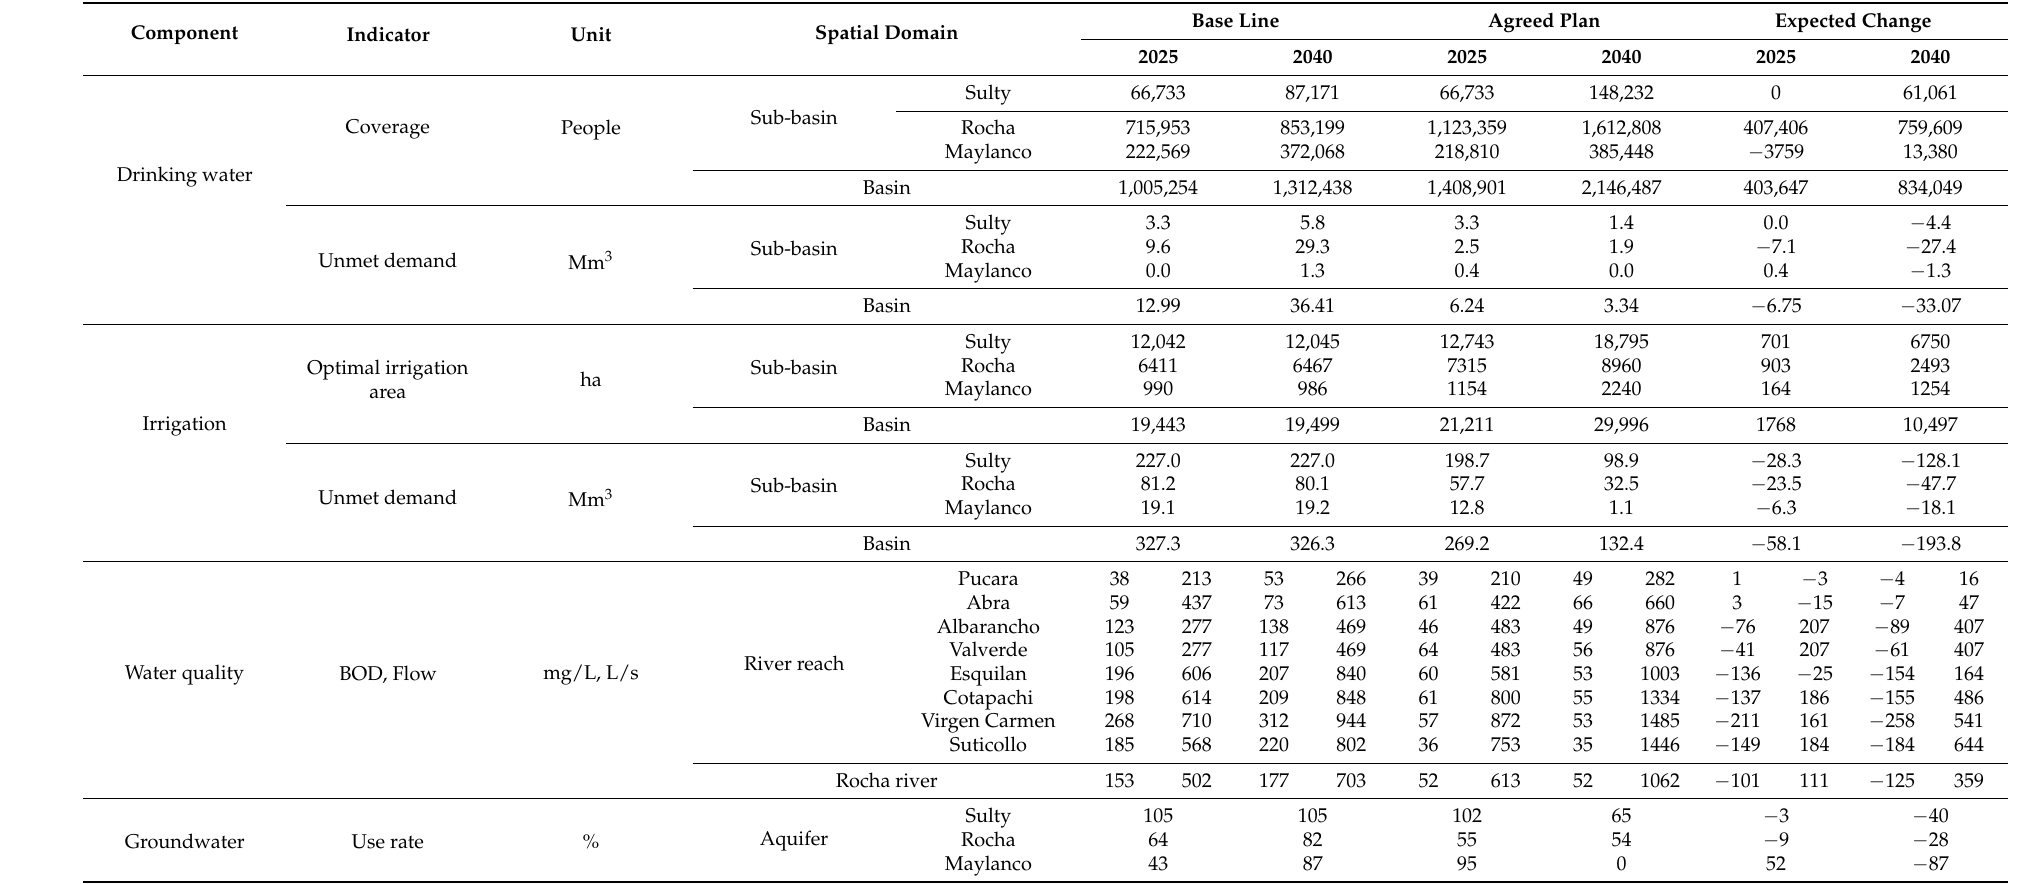
Table 5. Performance of the proposed actions (2025 and